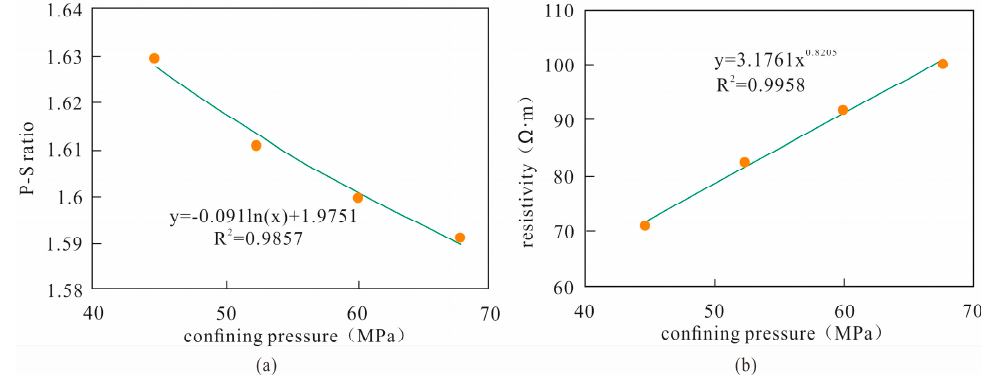
Figure 11. Curves of P − S wave ratio, resistivity and con fi ning pressure.